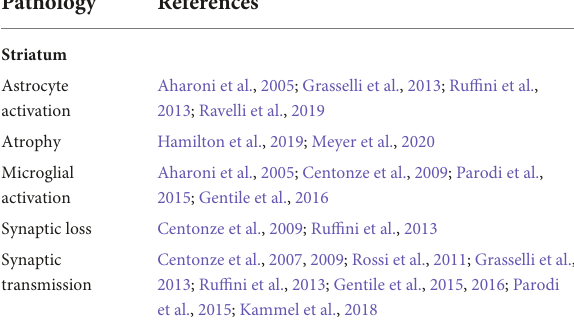
TABLE 4 Pathologies in the striatum in